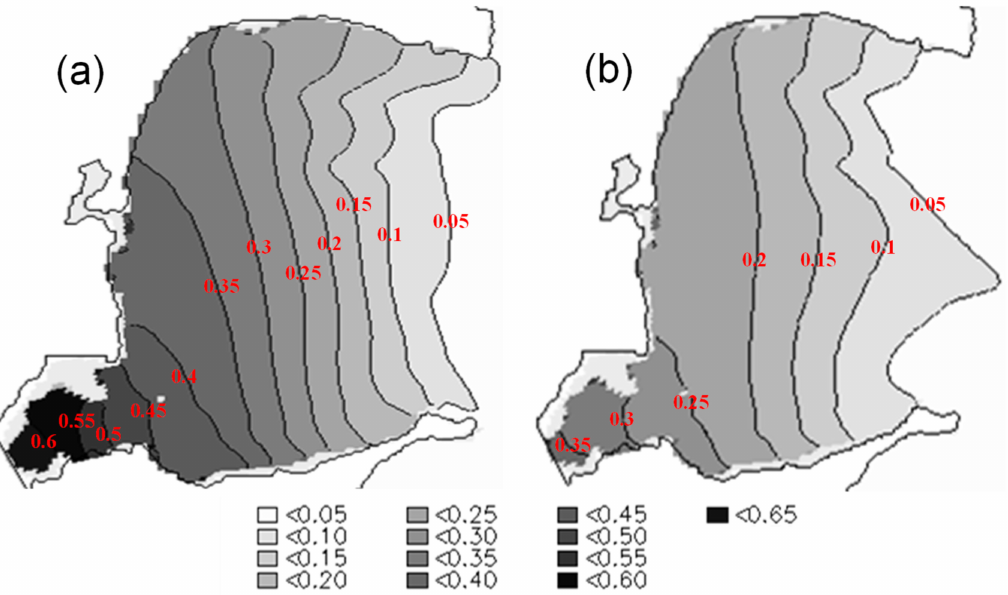
Figure 9. Concentration distributions of the conceptual substance (dimensionless) in Sungo Bay after 40 d of diffusion for cases of ( a ) bivalve culture and ( b ) no culture in the